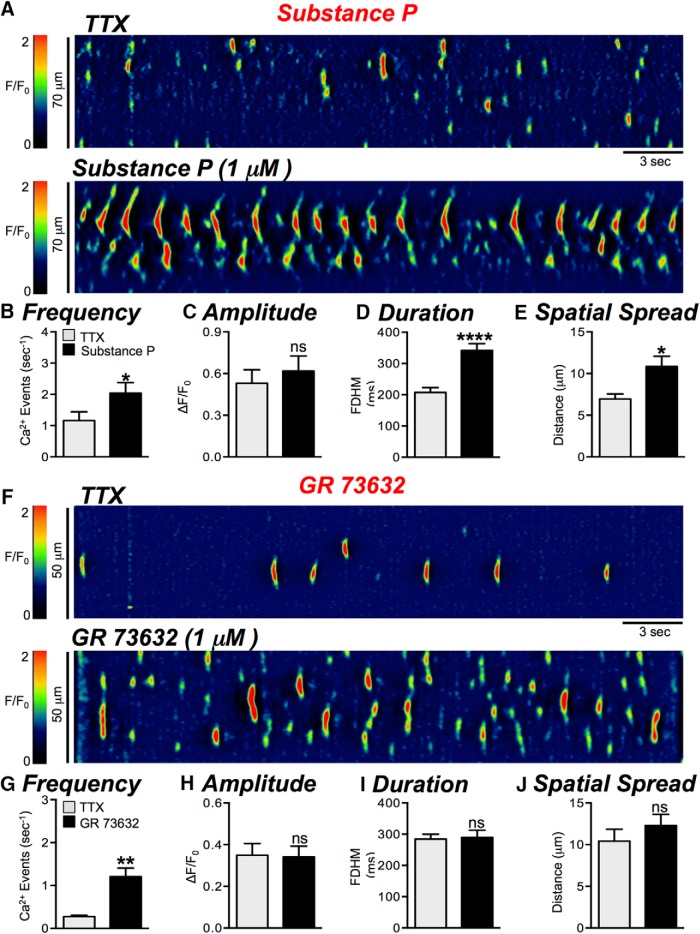
Neurokinin receptor (NK1) agonists activate Ca2+ transients. A, Representative ST maps showing the excitatory effects of SP (1 μM; in the presence of TTX) on Ca2+ transients in ICC-DMP. B–E, Summary graphs showing the effects of SP (in the presence of TTX) on the frequency (B), amplitude (C), duration (D), and spatial spread (E) of Ca2+ transients in ICC-DMP. F, Representative ST maps showing the excitatory effects of the NK1 receptor agonist GR 73632 (1 μM; in the presence of TTX) on Ca2+ transients in ICC-DMP (n = 4, c = 10). G–J, Summary graphs quantifying the effect of GR 73632 on the frequency (G), amplitude (H), duration (I), and spatial spread (J) of basal Ca2+ transient activity in ICC-DMP (n = 4, c = 9); ns = p > 0.05, *p < 0.05, **p < 0.01, ****p < 0.0001.